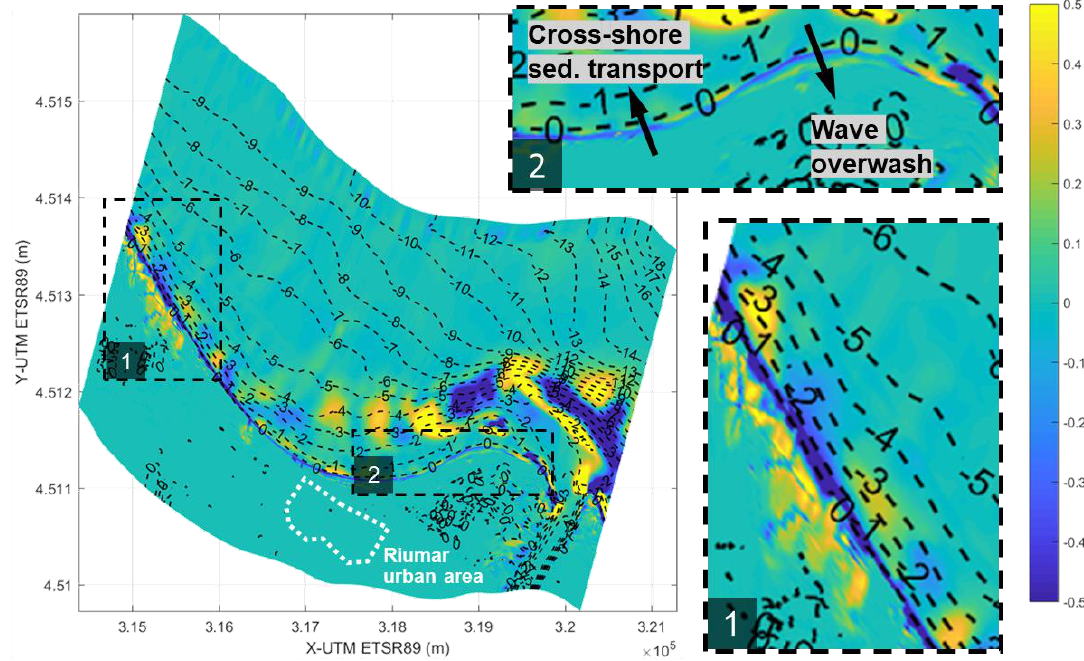
Figure 11. Post-storm erosion / accumulation patterns associated to scenario 1 (current climate without storm surge, SL = 0 m) due to the impact of an east-northeastern storm of 100-year return period. The areas where sediment is eroded are colored in deep blue while the areas where sediment is accumulated are shown in light yellow. Color bar (units in meters): in deep blue, accumulated erosion throughout the simulation; in light yellow, accumulated accretion.